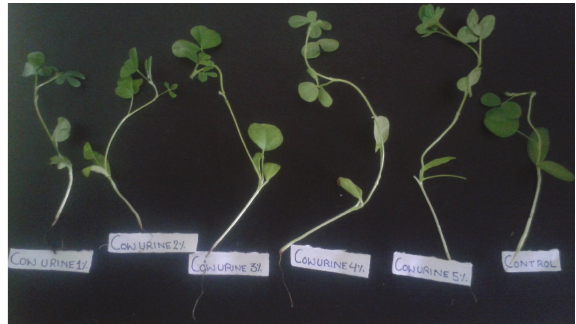
Figure 3: Effect of different concentrations (1%, 2%, 3%, 4%, and